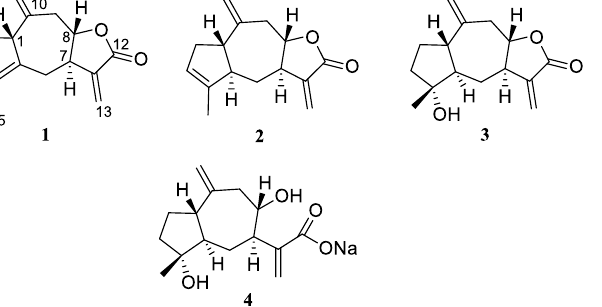
Figure 1. Structures of centaurolide-A ( 1 ), -B ( 2 ), inuviscolide ( 3 ), and alcohol derivative ( 4 ). Centaurolides 1 and 2 have the same molecular formula C 15 H 18 O 2 as it was evidenced by the sodiated molecular peaks at m/z 253.1199 and 253.1197, in their positive HRESI-MS spectra, respectively. 1 H and 13 C NMR data of 1 and 2 (CDCl 3 , Tables 1 and 2) indicated that both compounds are characterized by the same tricyclic sesquiterpene skeleton, ex- hibiting two exomethylene groups, a vinyl methyl, and a lactone